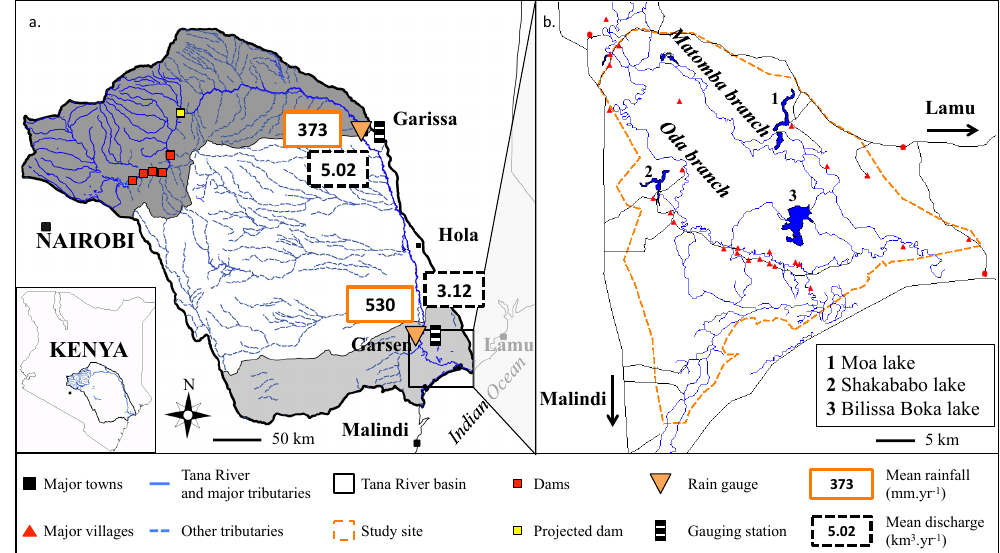
Fig. 1. (a) The Tana River basin and its main hydrological characteristics. The location of the precipitation and discharge data used for this study are specified. The sub-basins before the Garissa and after the Garsen gauging stations are presented in dark and light grey, respectively. (b) The Tana River Delta, its major channels, lakes, villages and